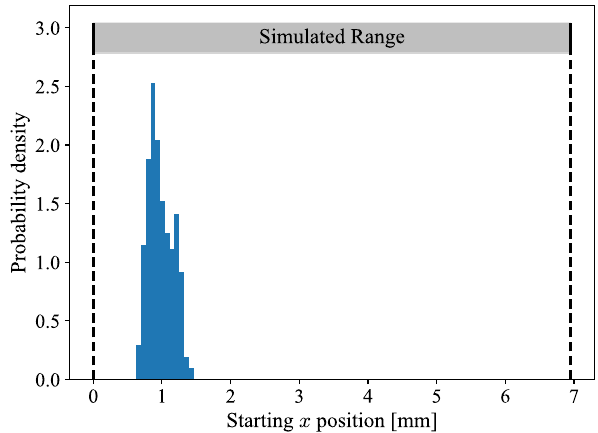
FIG. 17. Histogram showing the most likely horizontal starting positions as determined from the MC simulations. A concen- tration is found around 0.87 mm, for this particular UFO event.